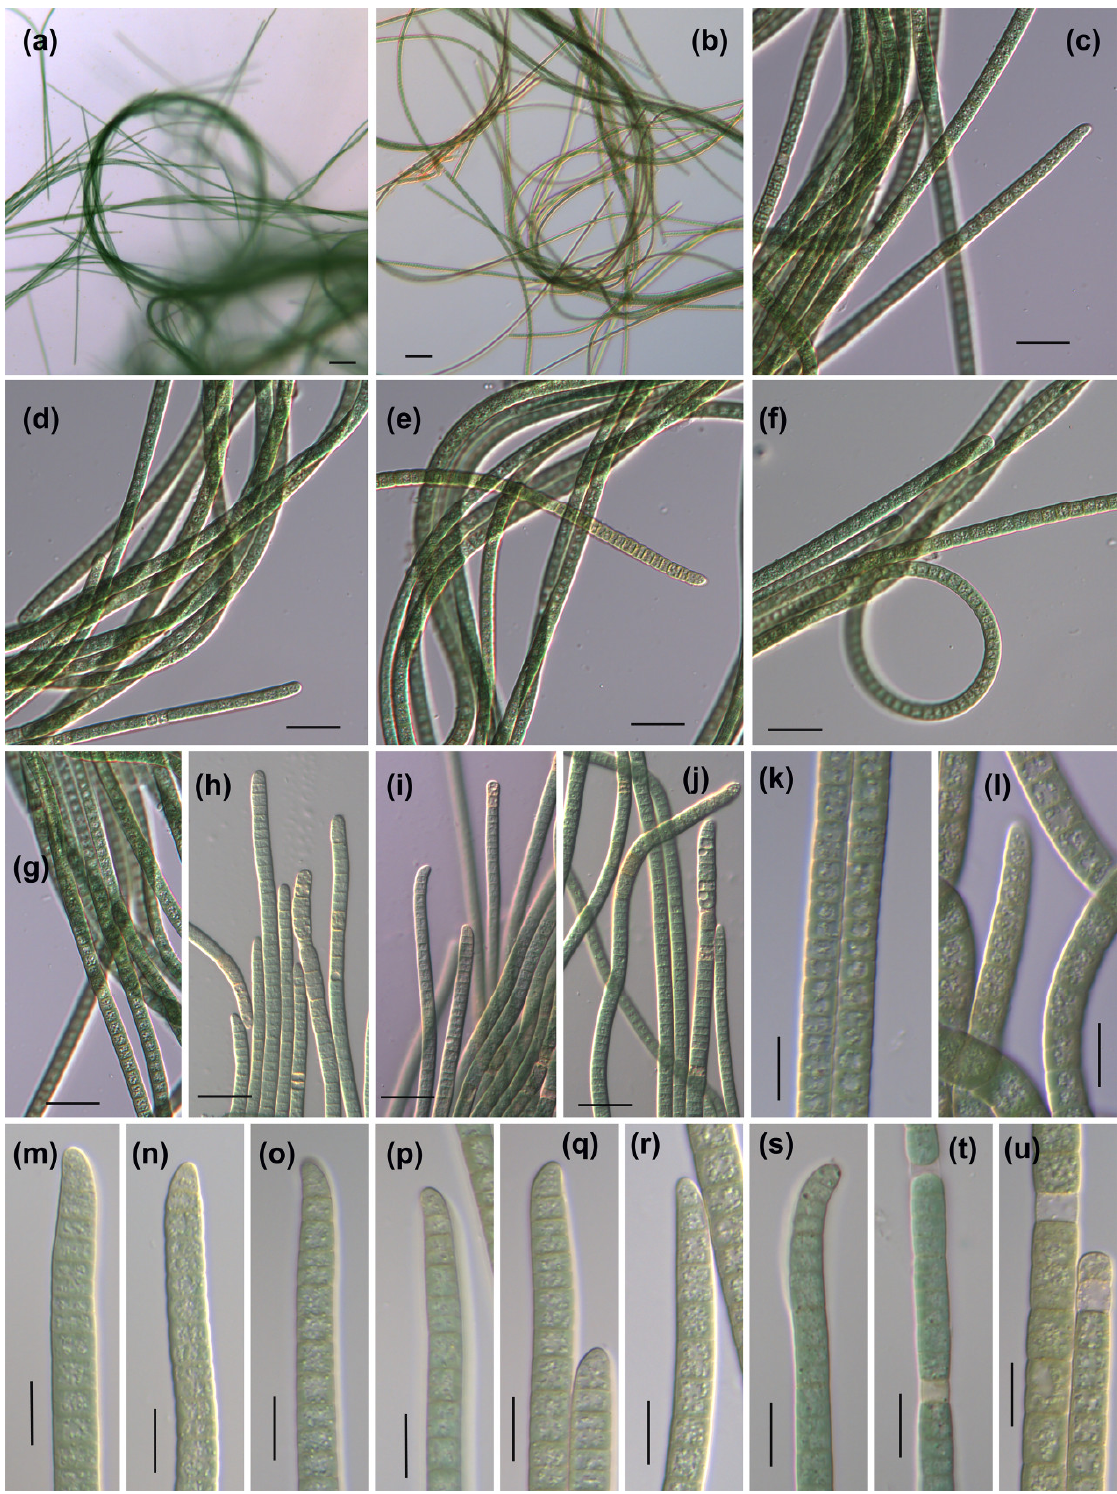
Figure 2. Light microscopy of Phormidium -like sp. 1 strains: ( a – f ) The filaments are densely entangled with each other; ( g – j ) different shapes of filaments, some apical cells rounded, some apical cells conical-rounded and narrowed; ( k , l ) trichomes slightly constricted at the crosswalls; ( m – s ) details of the conical-rounded and narrowed apical cells; ( t , u ) details of the thin and colorless sheath. Scale bars: ( a , b ) = 50 μm, ( c – j ) = 20 μm, ( k – u ) = 10 μm. Habitat: River benthos near to riverbank.